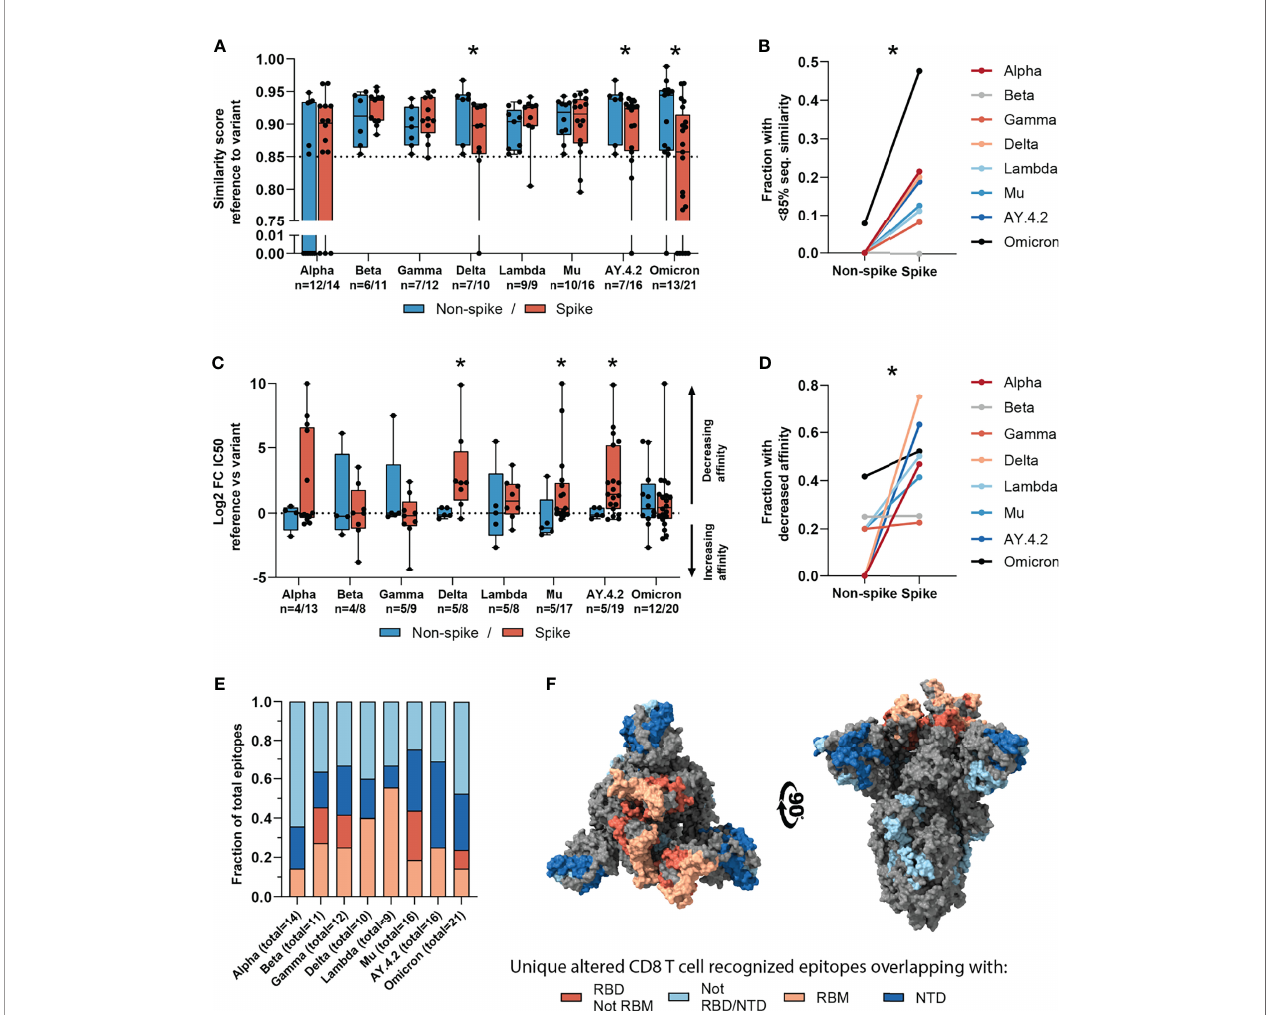
FIGURE 4 | Sequence similarity and predicted binding af fi nity of spike- versus non-spike-derived mutated CD8 T cell recognized epitopes. (A) Box plot comparing the sequence similarity of the altered spike and non-spike protein-derived CD8 T cell recognized epitopes, to the reference epitopes. Sequence similarity of indicated epitopes is set to zero as a result of one or more deletions/insertions in the epitope sequence (Alpha, n = 6/3; Delta, n = 0/2; AY.4.2, n = 0/2; Omicron, n = 1/12). (B) Fraction of spike versus non-spike protein-derived epitopes where the sequence similarity of the epitope to the reference epitope dropped below 85% as a result of the mutation. (C) Box plot comparing the log2 fold change in predicting binding af fi nity of spike and non-spike protein-derived CD8 T cell recognized epitopes to the corresponding HLA restriction element, as a result of the mutation. (D) Fraction of spike versus non-spike protein-derived CD8 T cell recognized epitopes where the predicted binding af fi nity of the epitope to the corresponding HLA restriction element was decreased ( ≥ 2-fold change in IC50) as a result of the mutation. (E) Fractions of unique spike protein-derived CD8 T cell recognized epitopes overlapping with a mutation located in the N-terminal domain (NTD), receptor-binding domain (RBD), receptor-binding motif (RBM) or a mutation located outside of these domains. (F) SARS-CoV-2 spike trimer in the open conformation with one erect RBD. Colors represent unique altered CD8 T cell recognized epitopes overlapping with the indicated domains. Image produced with ChimeraX using PDB accession: 6ZGG. Box plots indicate the median (line), 25th and 75th percentile (box), min and max (whiskers), and all data points (single circles). Statistical signi fi cance was tested with a two-tailed Mann – Whitney U test (A, C) or with a two-tailed Wilcoxon matched-pairs signed rank test (B, D) . Variation in numbers of epitopes in the analyses are due to inclusion of epitopes binding one or more HLA restriction elements. *P < 0.05. n indicates the number of epitopes analyzed per